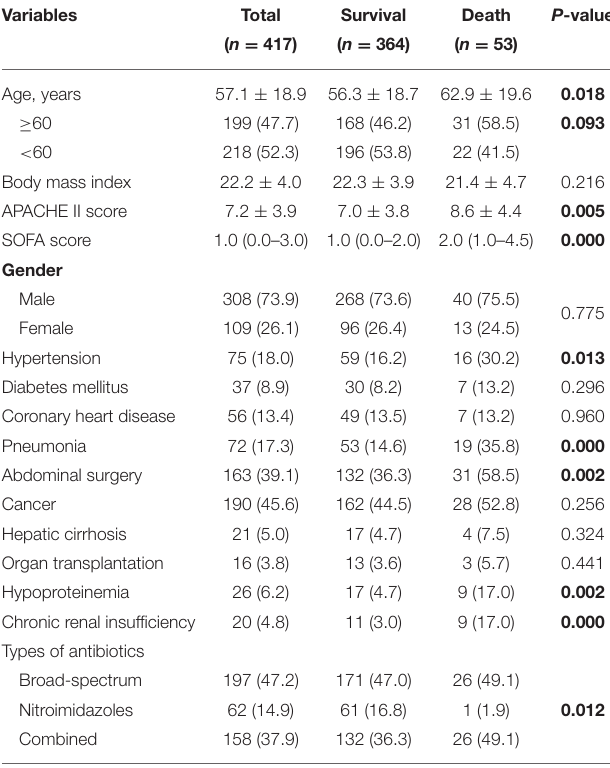
TABLE 1 | Univariate analysis of in-hospital death in patients with